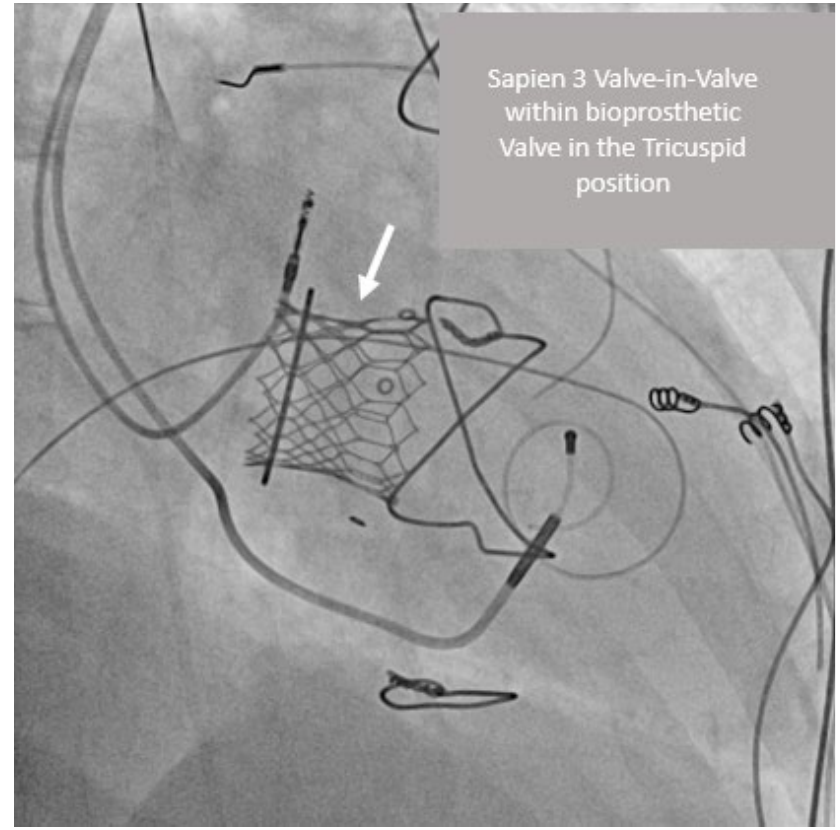
Figure 2. Sapien 3 valve-in-valve within bioprosthetic valve in the tricuspid position with pacemaker leads in situ in the RAO38 Caudal 10 view.